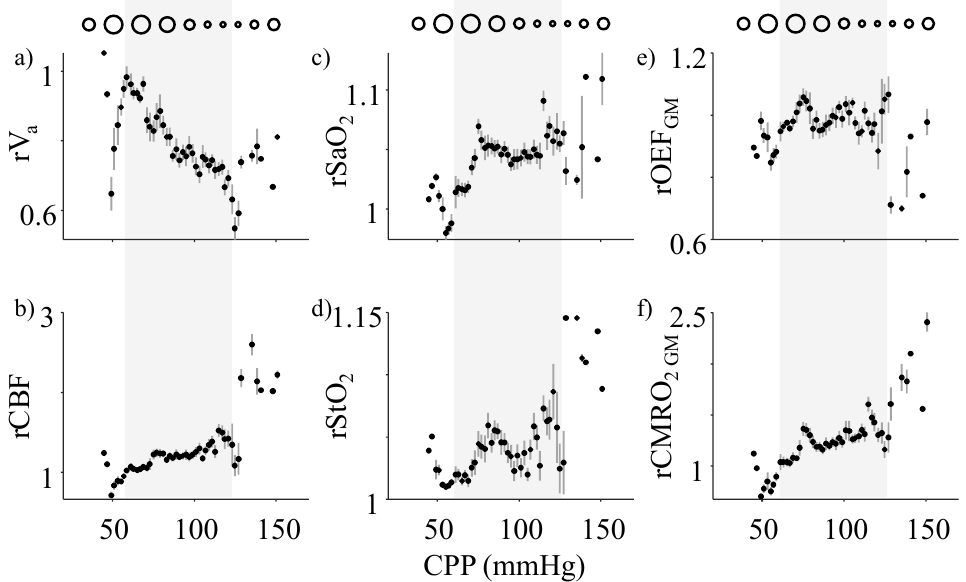
Figure 2. Trends in different oxygenation metrics with CPP. The circles at the top of each column show the expected trend of the vessel diameter changes with CPP. The different subfigures show trends in relative ( a ) arterial volume (rV a ), ( b ) cerebral blood flow (rCBF), ( c ) arterial oxygen saturation (rSaO 2 ), ( d ) tissue oxygen saturation (rStO 2 ), ( e ) oxygen extraction fraction (rOEF GM ), and ( f ) cerebral metabolic rate of oxygen (rCMRO 2GM ) as a function of CPP. The subscript GM is used for “general model” estimates. The approximate region of cerebral autoregulation is highlighted in gray across all panels. Every point on each graph indicates the mean value over a CPP bin of 2 mmHg and the gray vertical lines show ± 1 standard error of the mean across all